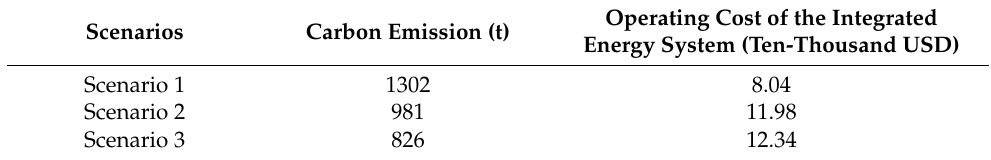
Table 3. Optimal solutions in different scenarios.